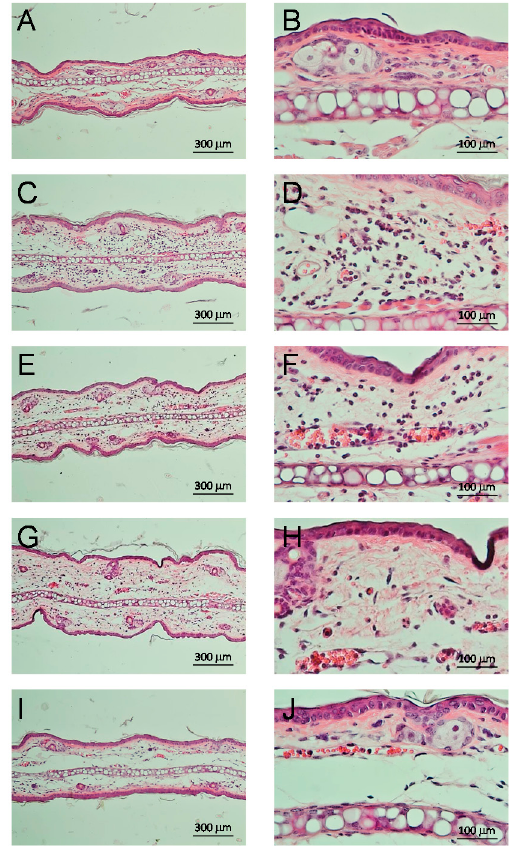
Figure 7. Representative histological sections from mice ears stained with hematoxylin-eosin (10×, left column and 40×, right column), after 4 hours of TPA application and 4-EAEP at different doses. ( A , B ) Basal; ( C , D ) TPA; 4-EAEP( E , F ) 0.56 mg/ear; ( G , H ) 1 mg/ear and ( I , J ) 1.71 mg/ear.